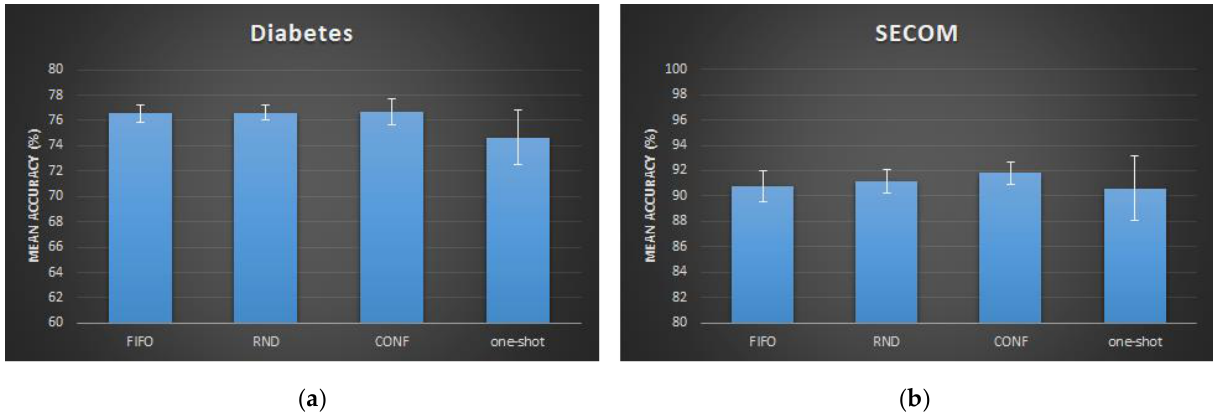
Figure 8. Mean accuracy with standard deviation bars of AutoDT on ( a ) Diabetes and ( b ) SECOM datasets with different memory approaches.